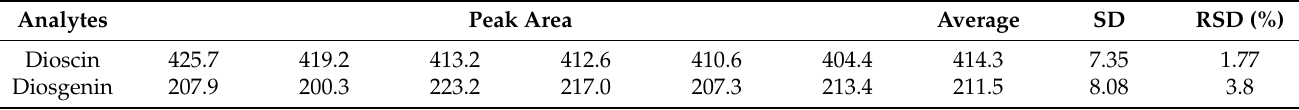
Table 6. Results of stability test ( n =